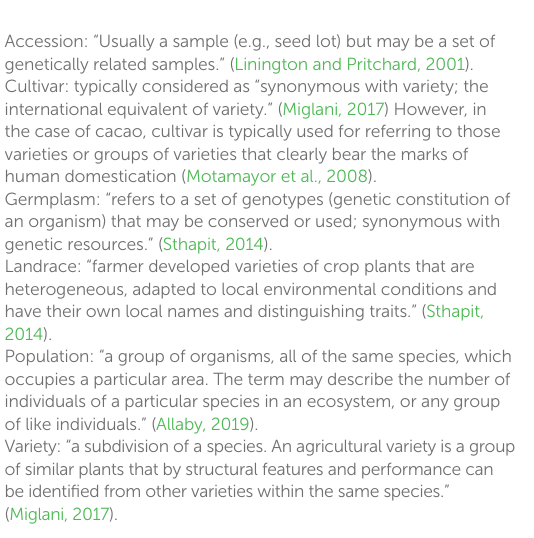
BOX 1: Cacao diversity